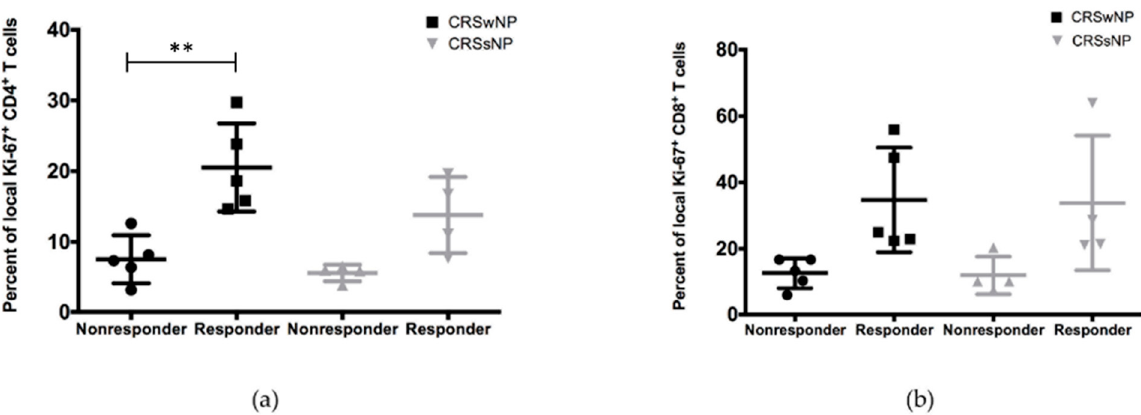
Figure 5. Subgroup analysis of local ( a ) CD4+ and ( b ) CD8+ T cells from patients with CRSwNP and CRSsNP based on their expression of Ki-67. Significant differences were measured between CD4+ T cells from CRSwNP.